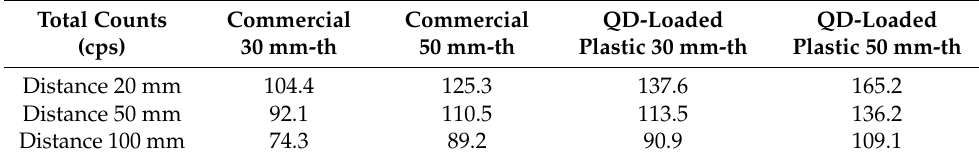
Table 2. The total count (cps) by plastic type and distance from the